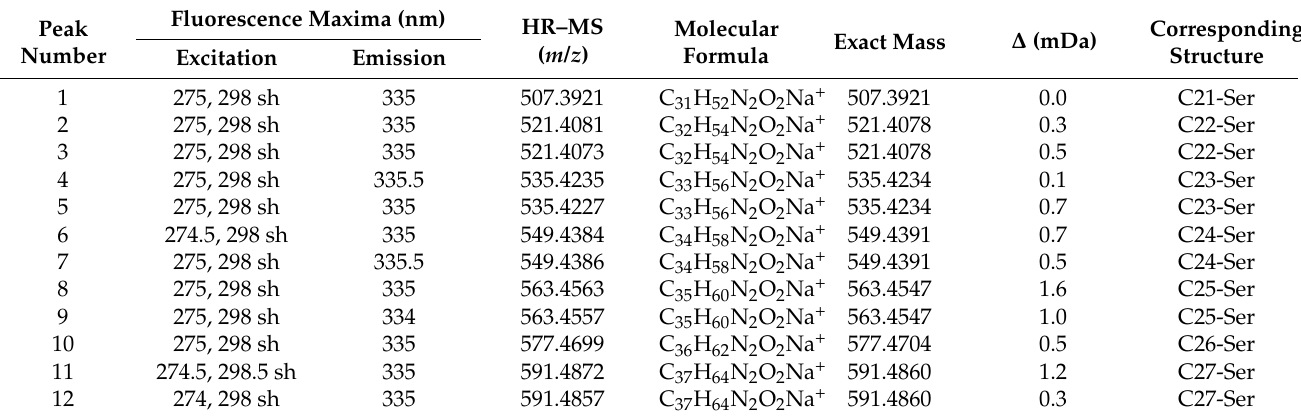
Table 1. Fluorescence excitation and emission maxima of the isolated compounds 1–12 (Figure 2) from inner seed coats of lemon and HR–MS data of these compounds. Further details are given in the Materials and Methods section.